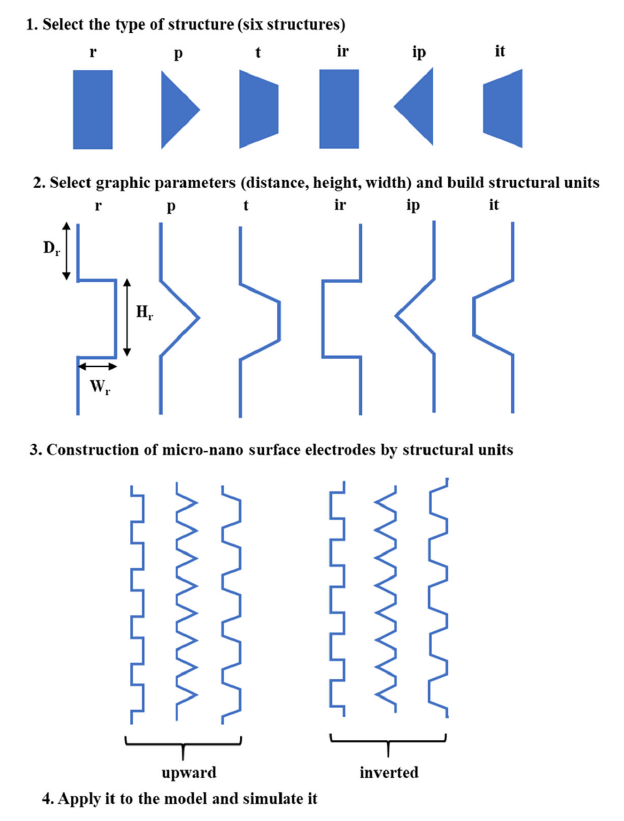
Figure 2. Design flow of micro ‐ nano surface electrodes.